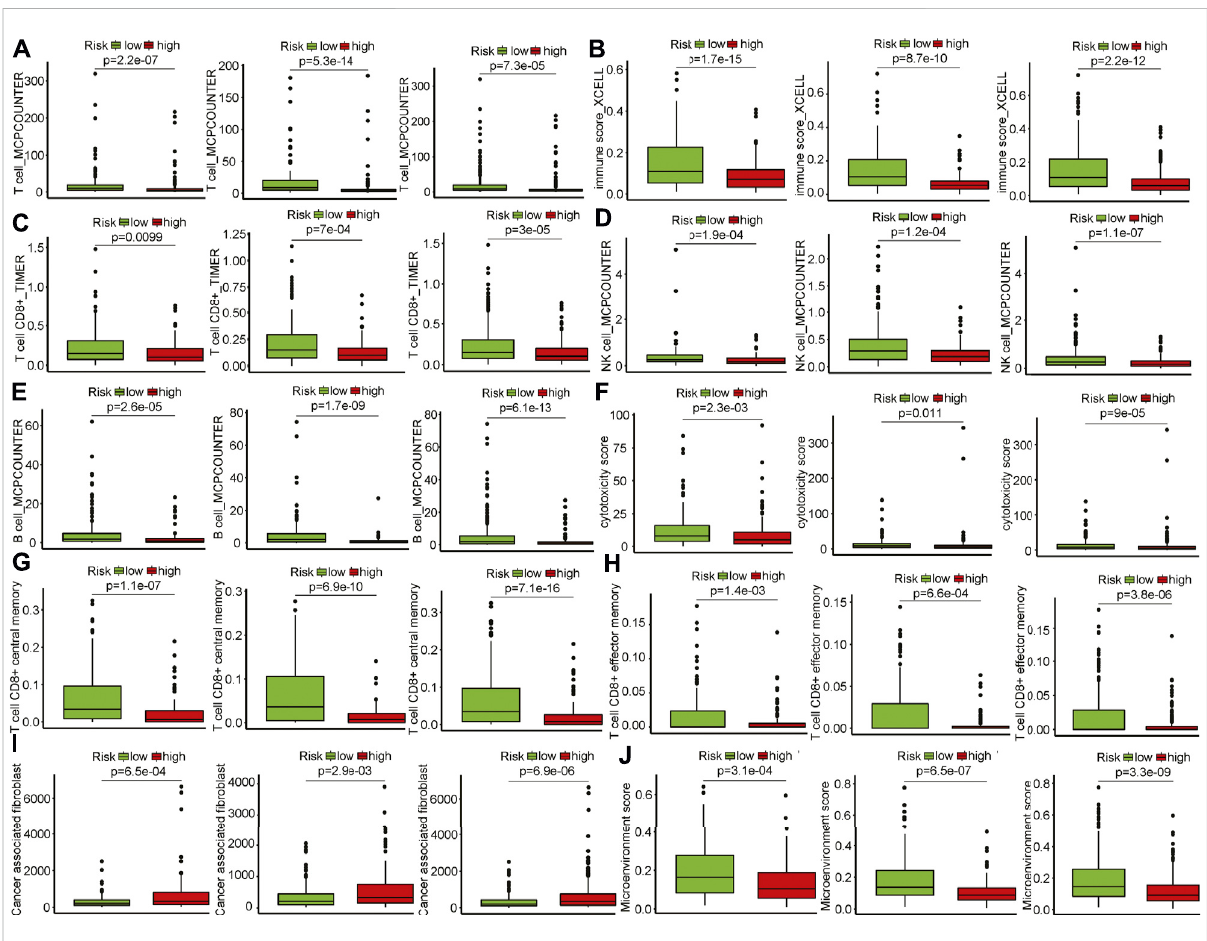
FIGURE 4 In fi ltrating cell type analysis using multiple deconvolution algorithms. (A) Total T cells in fi ltrated in patients of the high- and low-risk groups in training and validation sets (left to right: training, internal, entire HNSCC sets). (B) Immune score of patients in the high- and low-risk groups in trainingandvalidationsets(lefttoright:training,internal,entireHNSCCsets). (C) CD8 + Tcellsin fi ltratedinpatientsofthehigh-andlow-riskgroupsin training and validation sets (left to right: training, internal, entire HNSCC sets). (D) Natural killer cells in fi ltrated in patients of the high- and low- risk groups in training and validation sets (left to right: training, internal, entire HNSCC sets). (E) B cells in fi ltrated in patients of the high- and low-risk groups in training and validation sets. (left to right: training, internal, entire HNSCC sets). (F) Cytotoxicity scores of patients in the high- and low-risk groups in training and validation sets (left to right: training, internal, entire HNSCC sets). (G) Central memory CD8 + Tcells in fi ltrated in patients of the high- and low-risk groups in training and validation sets (left to right: training, internal, entire HNSCC sets). (H) Effector memory CD8 + T cells in fi ltrated in patients of the high- and low-risk groups in training and validation sets (left to right: training, internal, entire HNSCC sets). (I) Cancerassociated fi broblastsin fi ltratedinpatientsofthehigh-andlow-riskgroupsintrainingandvalidationsets(lefttoright:training,internal,entire HNSCC sets). (J) Microenvironment scores of patients in the high- and low-risk groups in training and validation sets (left to right: training, internal, entire HNSCC